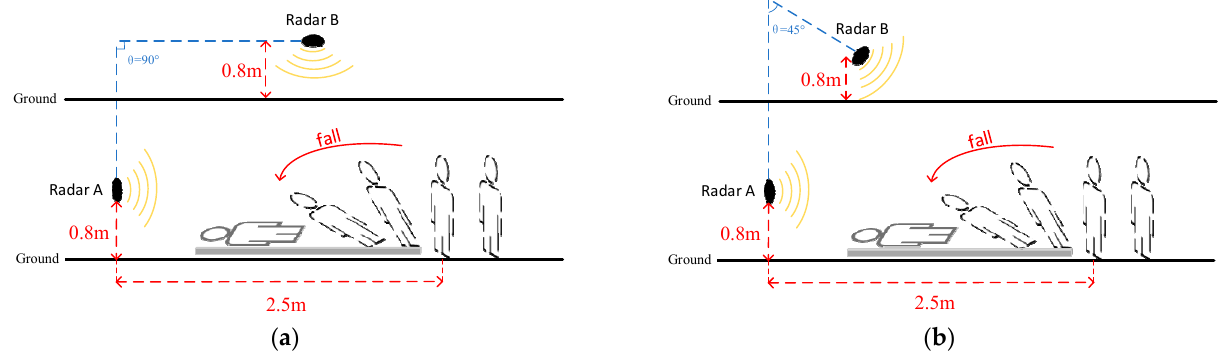
Figure 10. Schematic Diagram of Radar Experiment ( a ) The angle formed by two radars is 90 degrees; ( b ) The angle formed by two radars is 45 degrees.